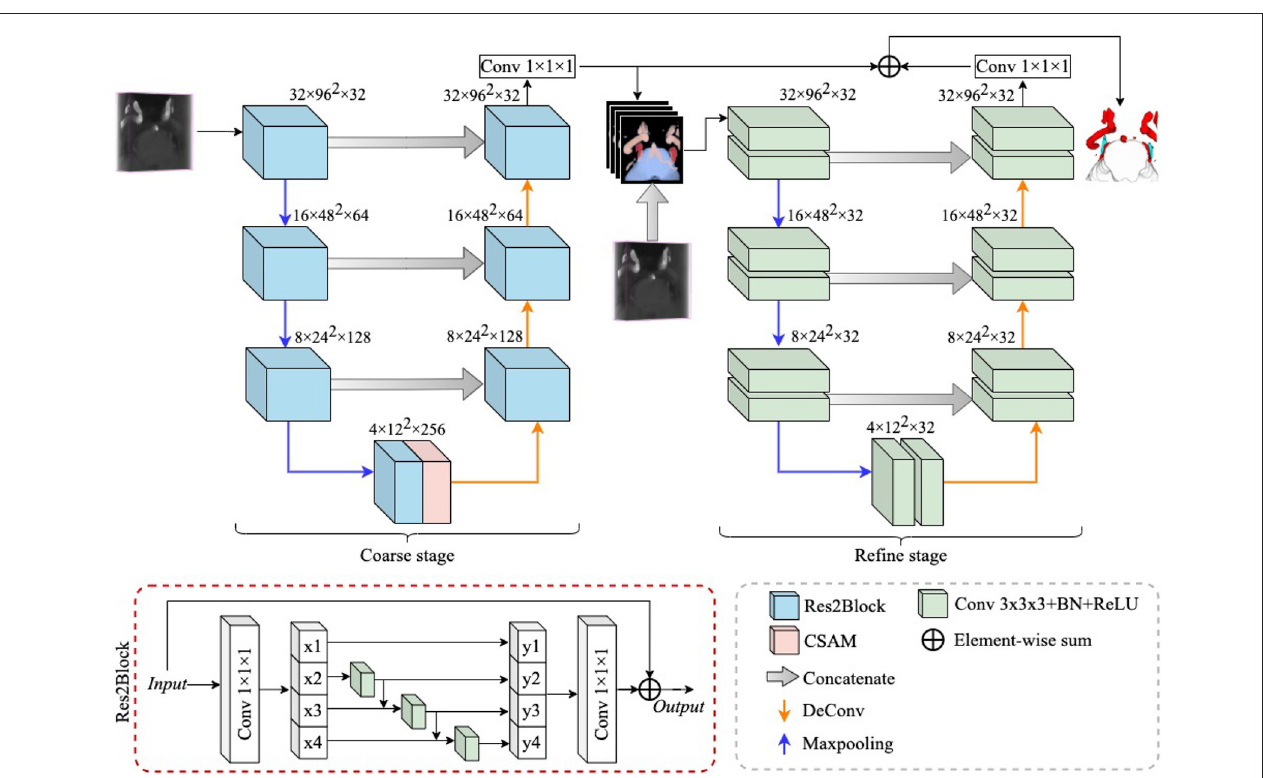
FIGURE 1 | The overall structure diagram of the proposed method. The proposed method consists of a coarse stage and a refine stage, where the feature extraction module in the coarse stage is replaced by ResBlock to Res2Block, while the refine stage uses 3D UNet as a refiner to further improve the segmentation performance. The details of the structure of the CSAM can be found in CS 2 -Net ( Mou et al., 2020).